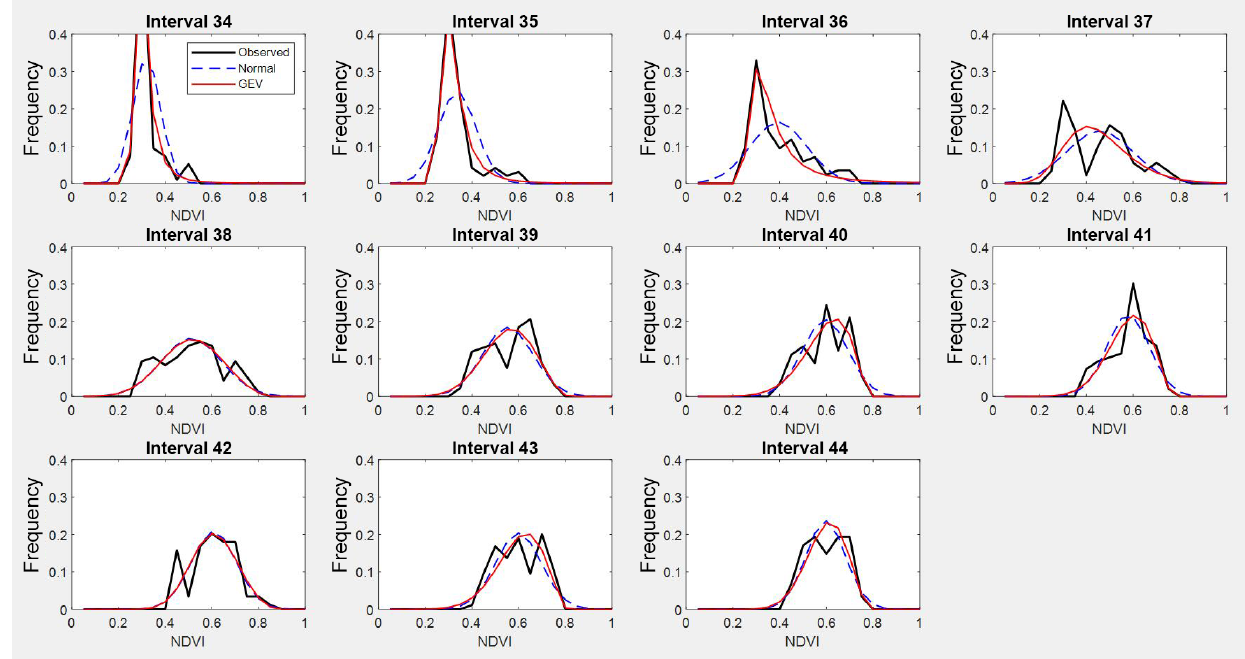
Figure A4. Observed NDVI, GEV and normal PDFs from interval 34 to interval 44 (from 22 September to 18 December) representing